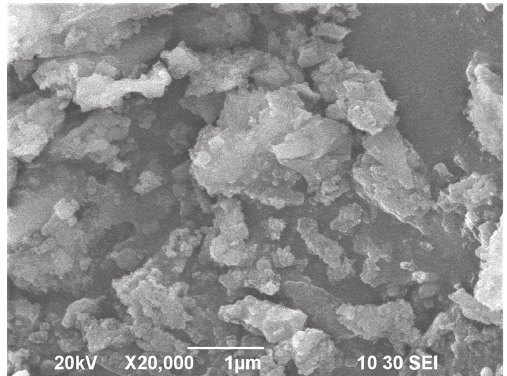
Figure 4: Scanning electron microscope image of calcined Ficus exasperata Leaf Table 1: Mix proportion of various mixes.